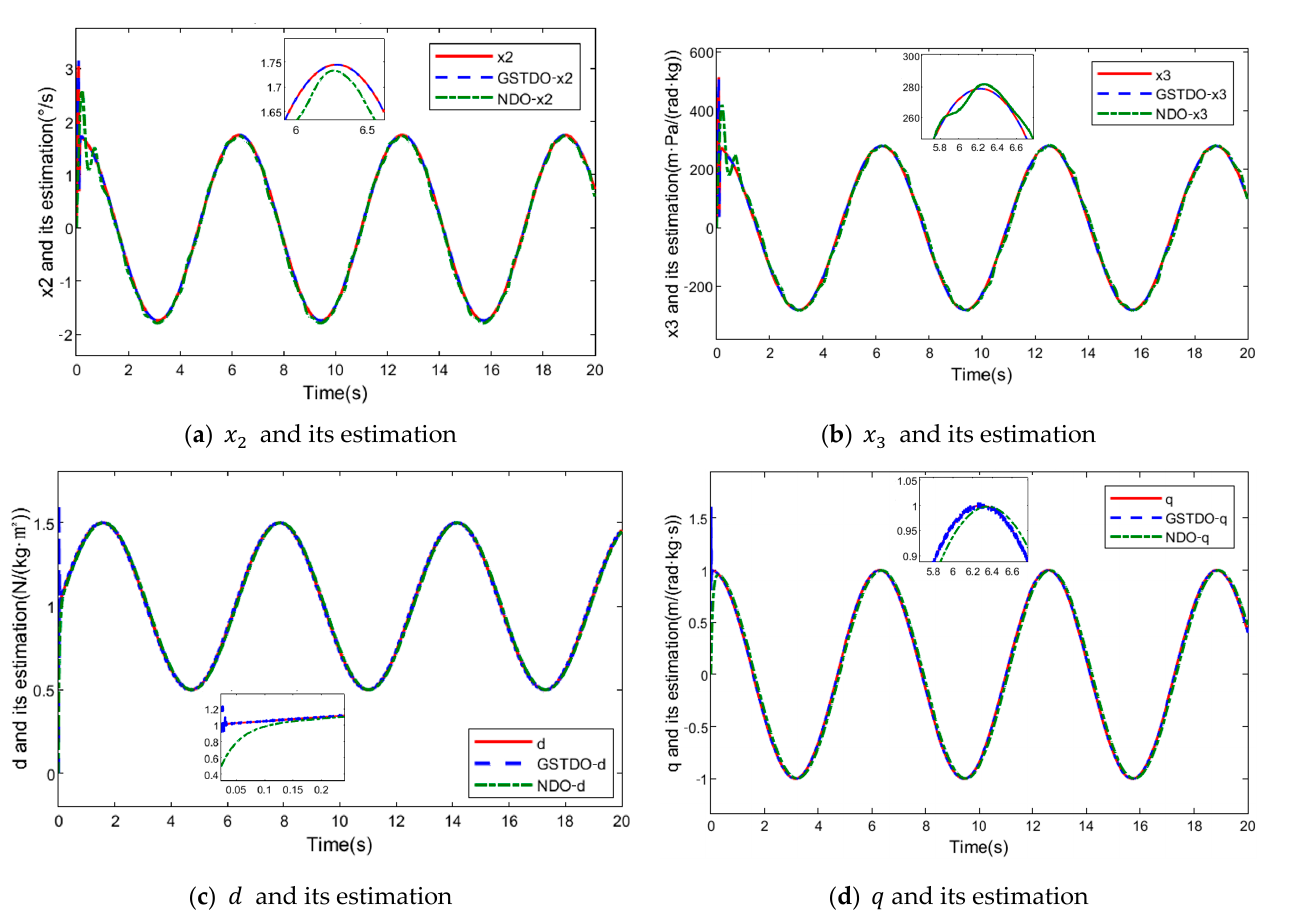
Figure 6. Comparison of the observational e ff ects of GSTDO and NDO in Experiment 1.